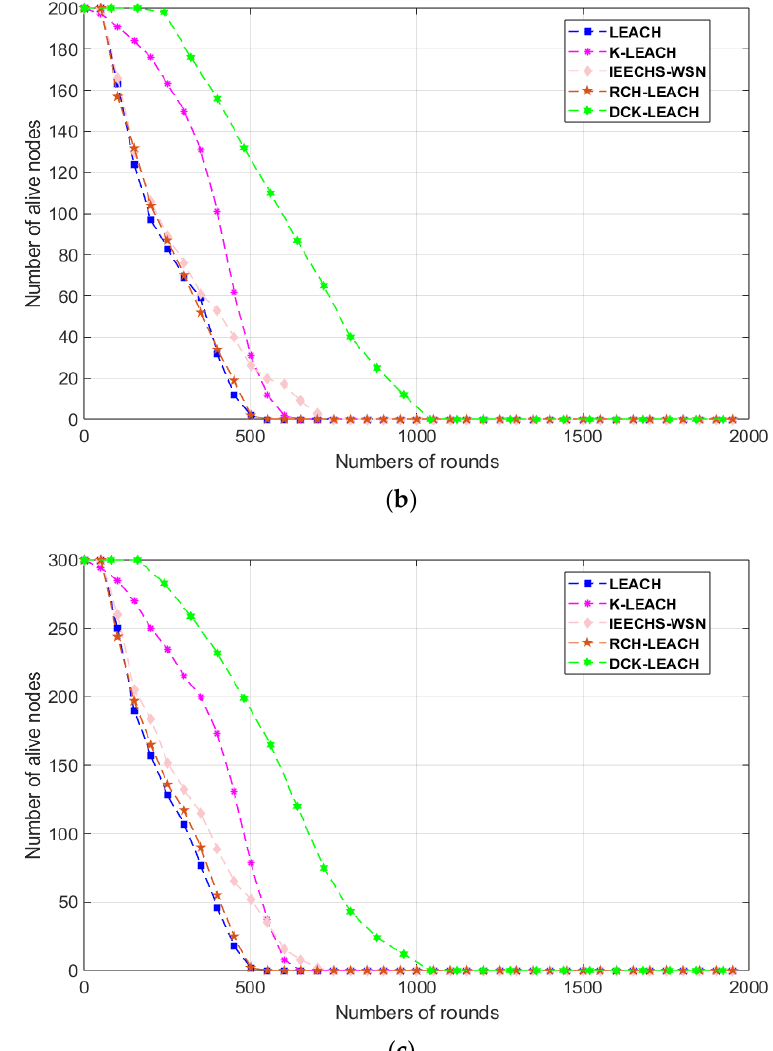
Figure 4. Comparison number of alive nodes in three scenarios: ( a ) 100 nodes, ( b ) 200 nodes, ( c ) 300 nodes.